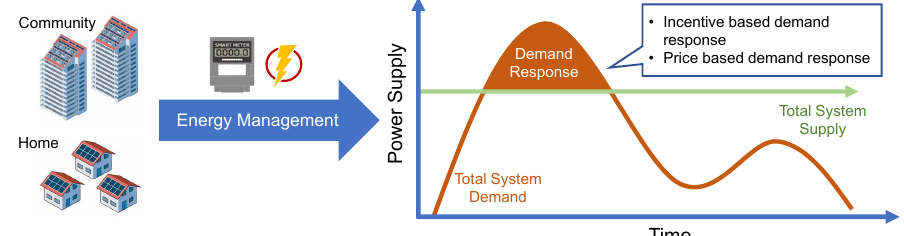
Figure 6. Demand response